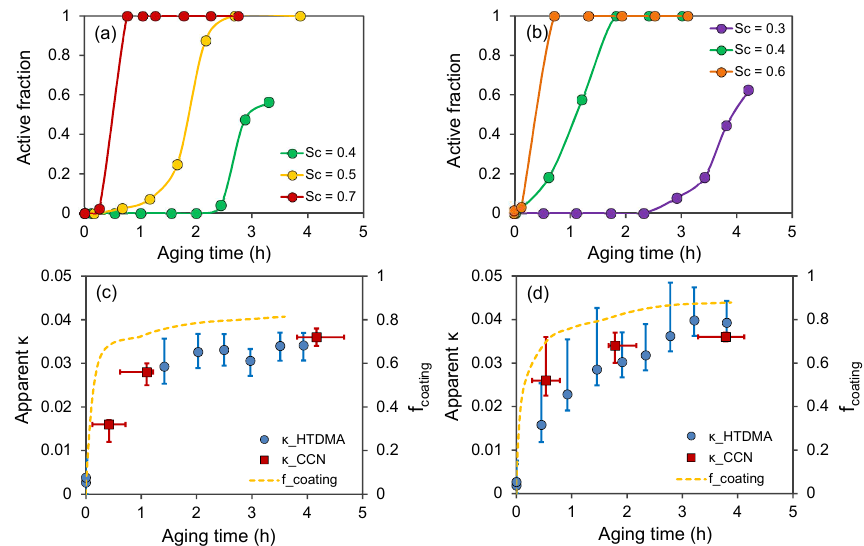
Figure 11. The active fraction of BC particles under diversified supersaturation (a, b) and the closure of apparent κ for BC particles with initial diameter (c, d) during ageing in two typical experiments. Panels (a, c) are the results from experiment 4 with 100nm BC particles and (b, d) represents experiment 6 with 150nm BC particles. Red square and blue circle in (c, d) represent the apparent κ calculated using CCN counter data and HTDMA data, respectively. Yellow dashed line represents the fraction of coating materials on BC particles. The error bars of κ _CCN and κ _HTDMA represent the uncertainty in the